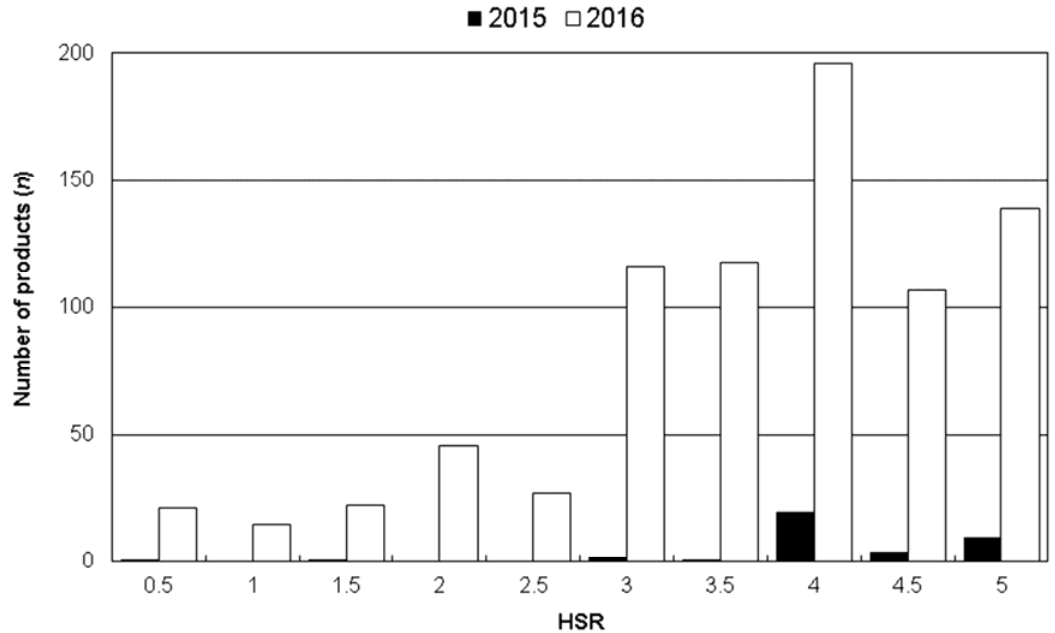
Figure 3. Number of products ( n ) displaying each Health Star Rating (HSR) (0.5 to 5 stars), in 2015 and 2016.